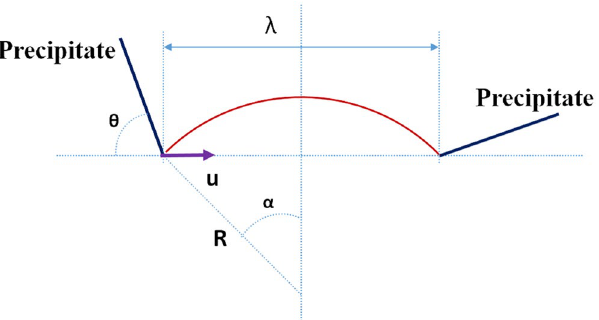
Figure 5. Dislocation-precipitate geometry for a pinned dislocation segment. The arrow indicates, as a reference, the initial unbowed dislocation line direction (u). For the precipitate on the left, the orientation angle θ is defined as measured clockwise from u to the trace of the broad facet of the precipitates. For the precipitate on the right, it is defined as measured counter clockwise.